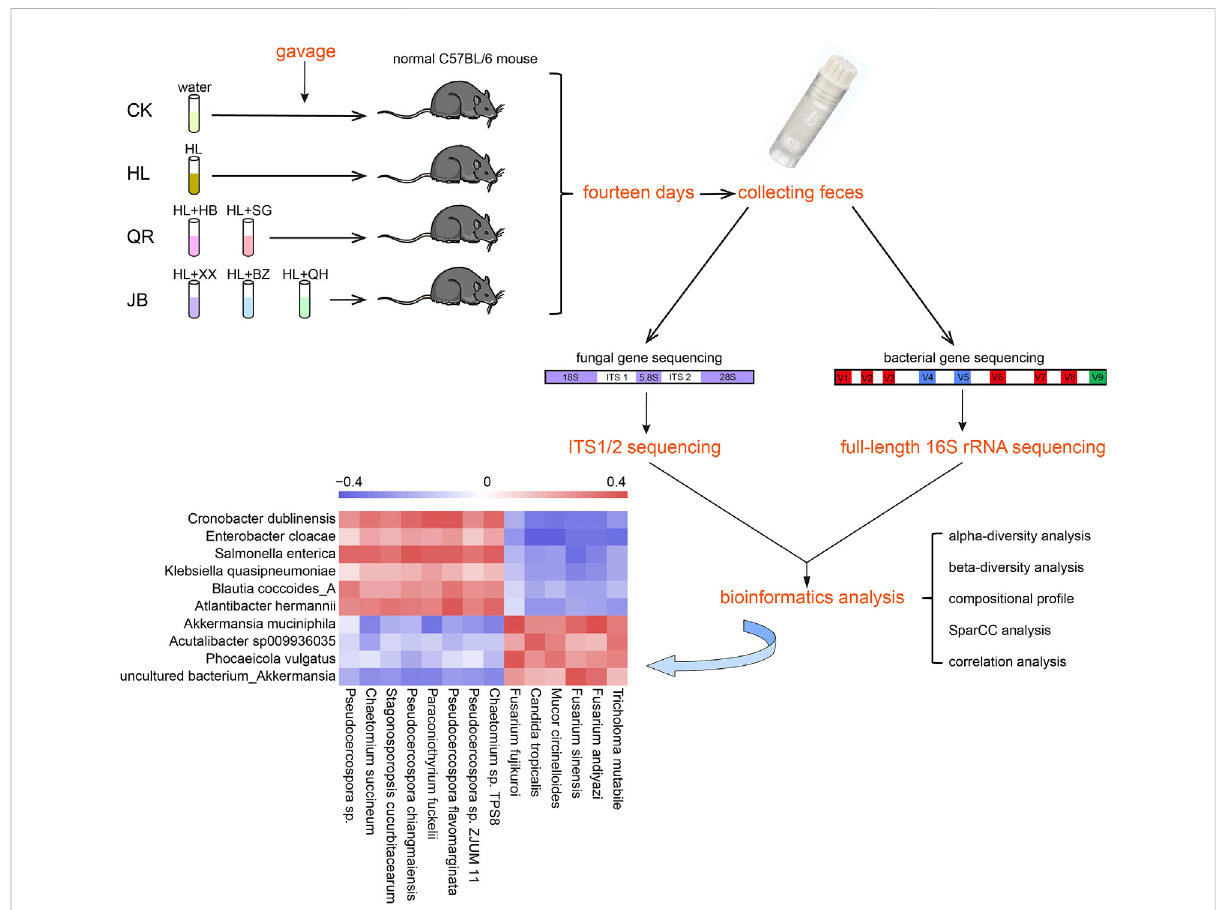
FIGURE 1 The design of experiment. Two antipyretic drugs and three diaphoretic drugs were selected to pair with Coptis chinensis for this study. The aqueous extract of each herbal pair was prepared and then orally administrated to male C57BL/6 mice by gavage at a clinical equivalent dose for fourteen days. The fecal DNA was extracted to conduct full-length 16 S rRNA sequencing and internal transcribed spacer 1/2 (ITS1/2) sequencing. The bioinformatics analysis was applied to investigate the alteration of gut bacterial and gut fungal community, as well as the correlation between gut bacteria and gut